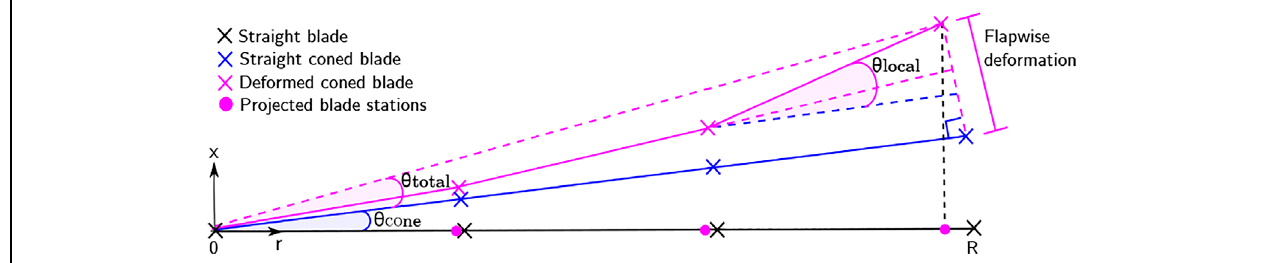
FIGURE 1 | Straight, coned and deformed blade stations, with relevant angles for projecting radial stations and velocity components.